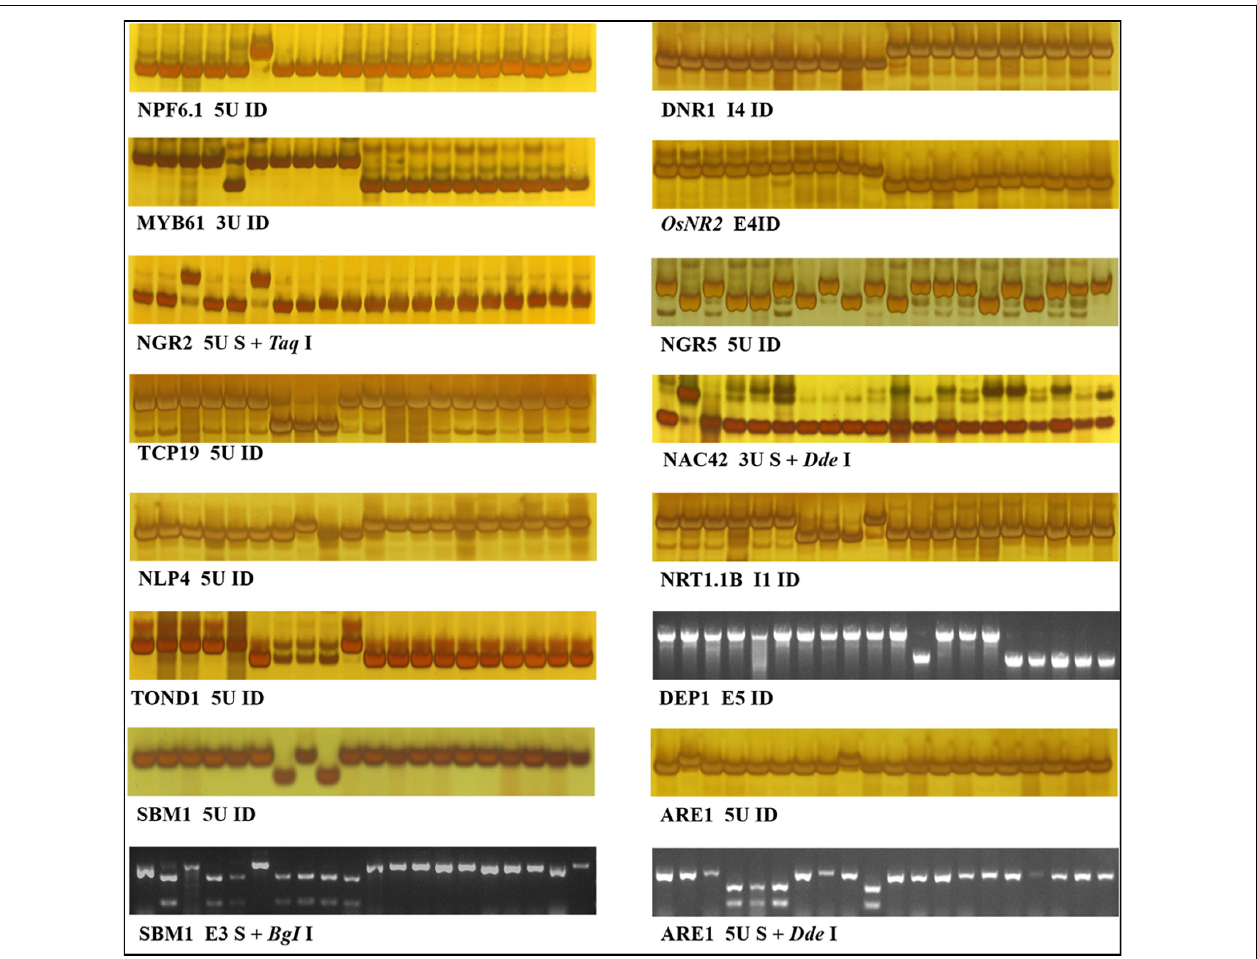
FIGURE 1 | Indel, CAPS, and dCAPS markers for 14 NUE genes. The 20 accessions used for marker evaluation were 9311, IR36, NM73, Guicao 2, Huagengxian 74, ZS97, Kasalath, Basmati 370, Dular, NJ11, 02428, Ballila, NIP, Kosh, KY131, Runnong11, Suxiu 867, Huaidao 5, Xudao 3, and Huageng5 (here from left to right). The first 15 accessions were germplasm accessions, including donors of the 14 NUE genes, and the other 5 accessions were mainstay cultivars in the Huang–Huai rice area of China. In the figure of marker “TOND1 5U ID,” no band was amplified from accession Kasalath, Basmati 370, and